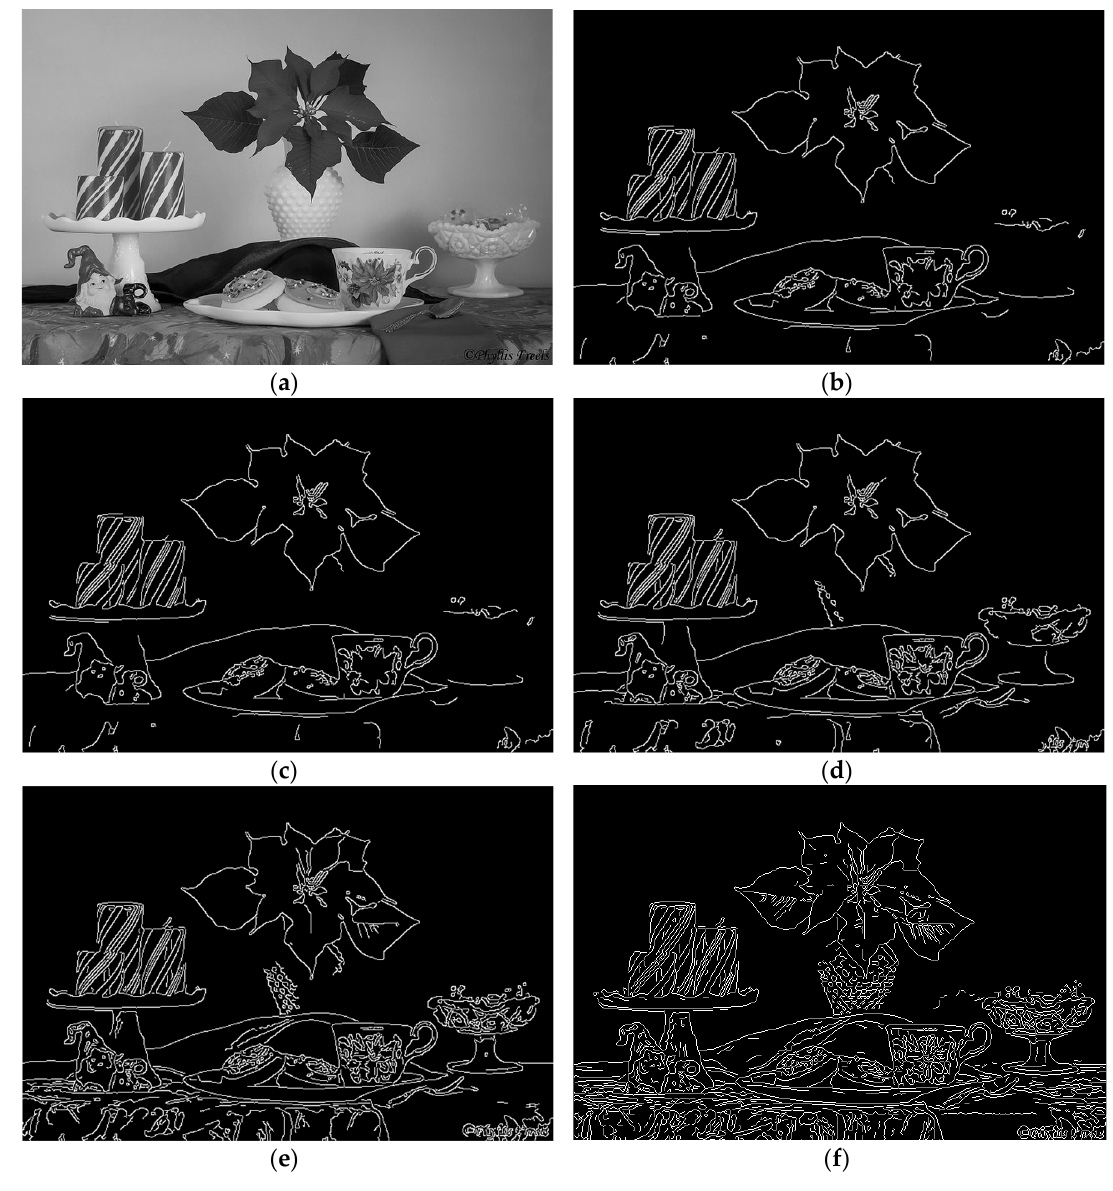
Figure 15. Glass vase image comparison results of different methods. ( a ) Original image (640 × 426) [20]; ( b ) Gao and Liu’s method (TH H = 148, TH L = 74); ( c ) Song et al. proposed method (TH H = 148, TH L = 17); ( d ) Saheba et al.’s method (TH H = 106, TH L = 27); ( e ) Li and Zhang’s method (TH H = 65, TH L = 26); ( f ) TCEDA.